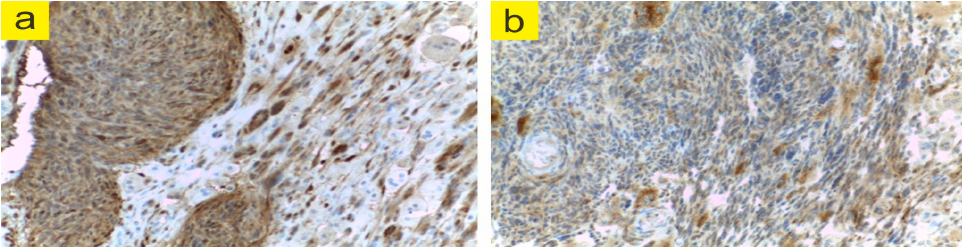
Figure 6. Histopathological modi fi cations in a patient with LAM and RA (images archive of the fi rst author). SMA positive ( a ). on the described nodular areas; CD34 positive ( b ). on the wallpaper of